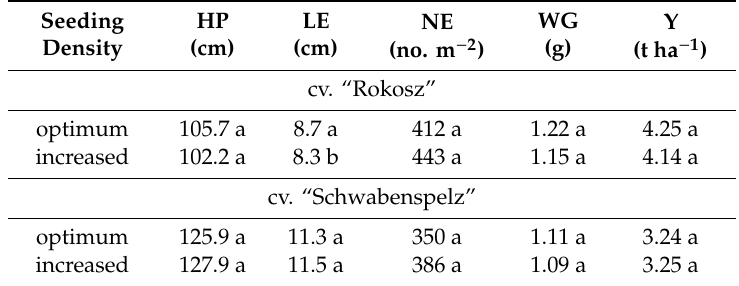
Table 7. The impact of seeding density on selected yield components and grain yield of the spelt wheat cultivars “Rokosz” and “Schwabenspelz” (mean for 2013–2015). HP–height of plant, LE–length of ear, NE–number of ears per m 2 , WG–weight of grains per ear,